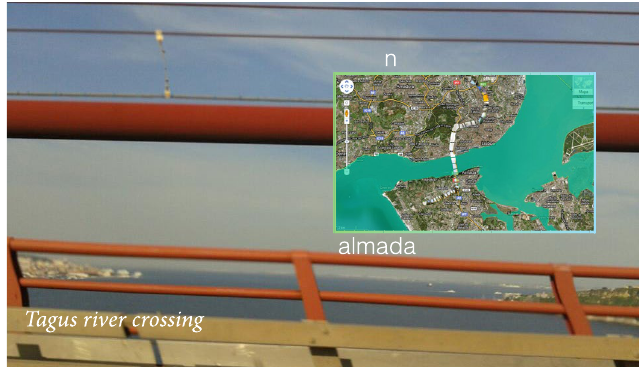
Fig. 2. Prototyping the journey between Almada and Lisbon